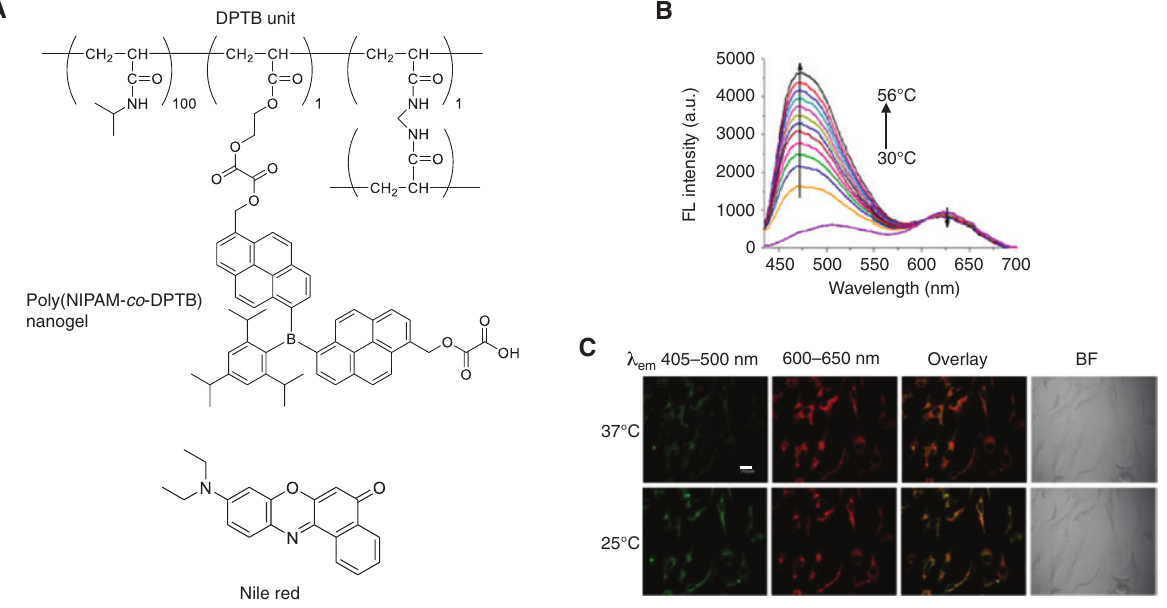
Figure 9: Ratiometric temperature sensing system composed of poly(NIPAM- co -DPTB) nanogel and Nile red. (A) Chemical structures of poly(NIPAM- co -DPTB) nanogel and Nile red. (B) Fluorescence spectra of a mixture of poly(NIPAM- co -DPTB) nanogel = 405 nm). (C) Confocal fluorescence images (leftmost and second), their overlay images and Nile red in water (0.5 mg/ml in total) ( λ ex (third from the left), and bright field (BF) images (rightmost) of NIH/3T3 cells labeled with poly(NIPAM- co -DPTB) nanogel and Nile red = 405 nm). Reproduced with permission from Liu et al. (2015). Copyright 2015 American Chemical ( λ ex